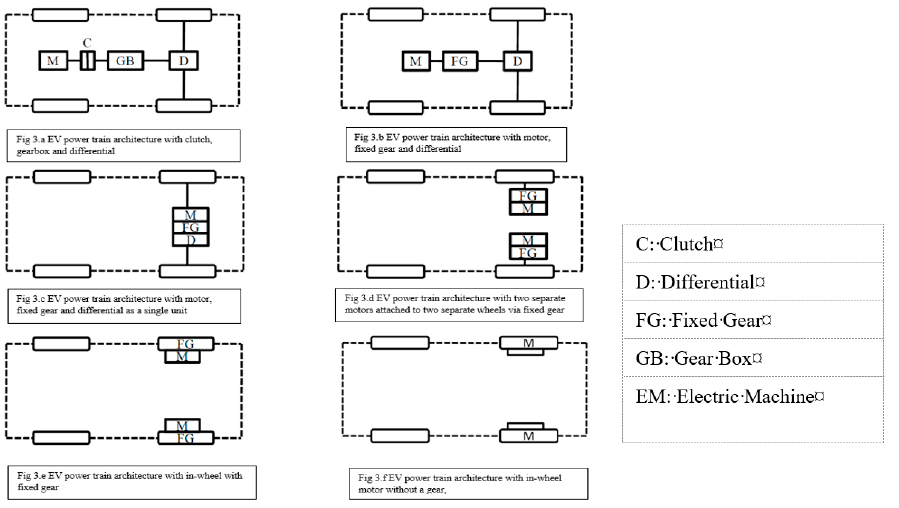
Figure 3. Electric vehicle (EV) drivetrain architecture alternatives based on drivetrain configuration [53].